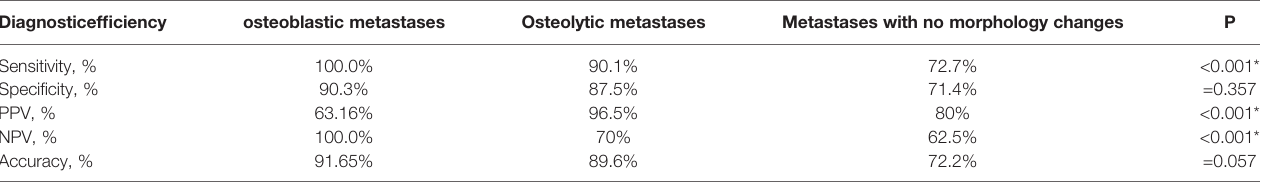
TABLE 6 | Diagnostic ef fi ciency of 68 Ga-P15-041 in different types of bone metastases. Diagnosticef fi ciency